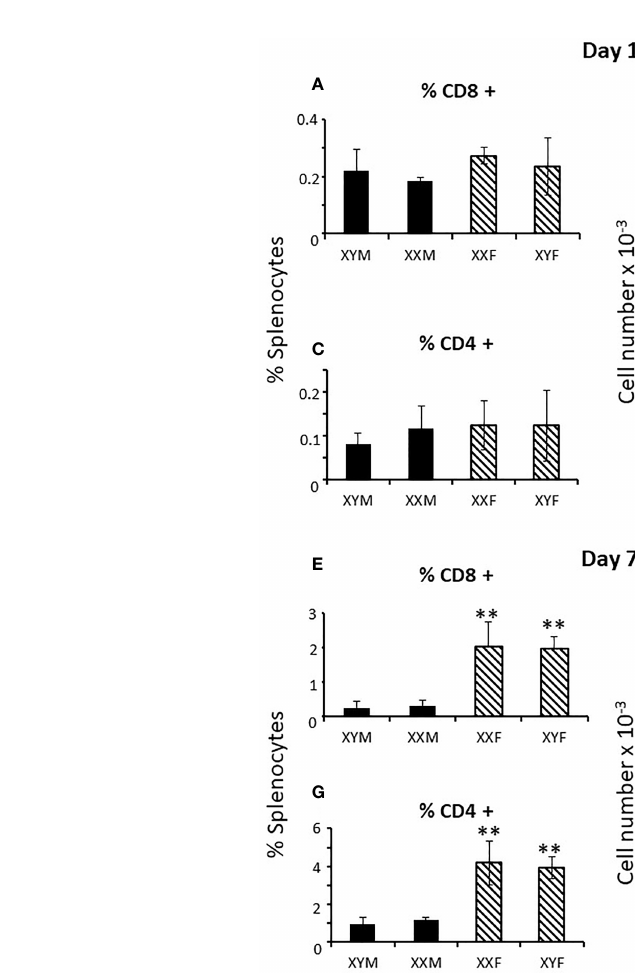
( Figure 7A ). The lack of effect of the drugs on cell content of the female spleen also indicated speci fi city of the effect.